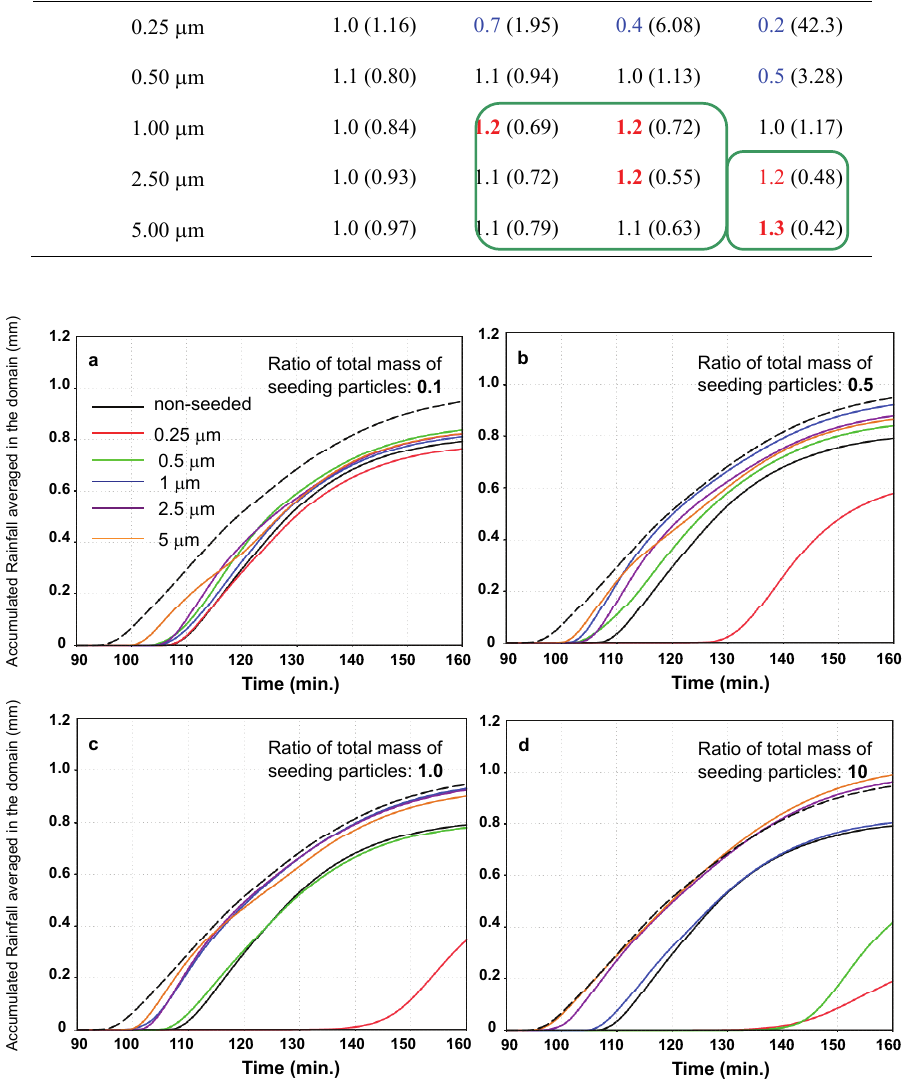
Fig. 8. Same as Fig. 7 except for stratiform